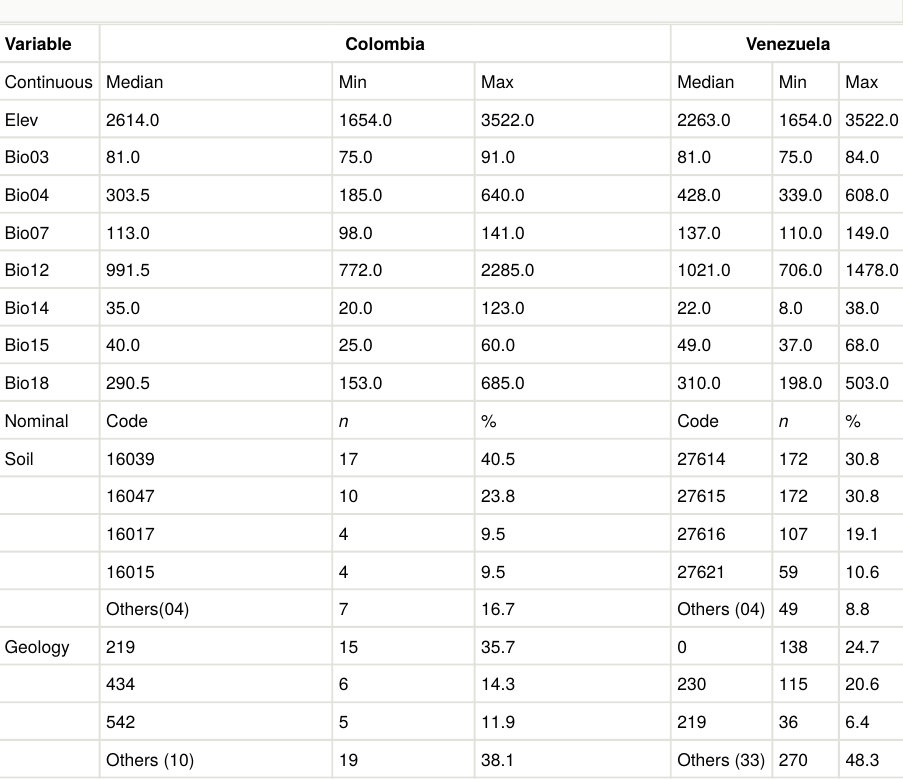
Summary statistics for explanatory variables used in ENMs for the 42 localities where Lesbia nuna has been recorded in Colombia and for the same elevational range in the Venezuelan Andes. In the categorical variables, “n” refers to the number of localities (Colombia) or the number of pixels (Venezuela). In Geology, codes correspond to those provided by